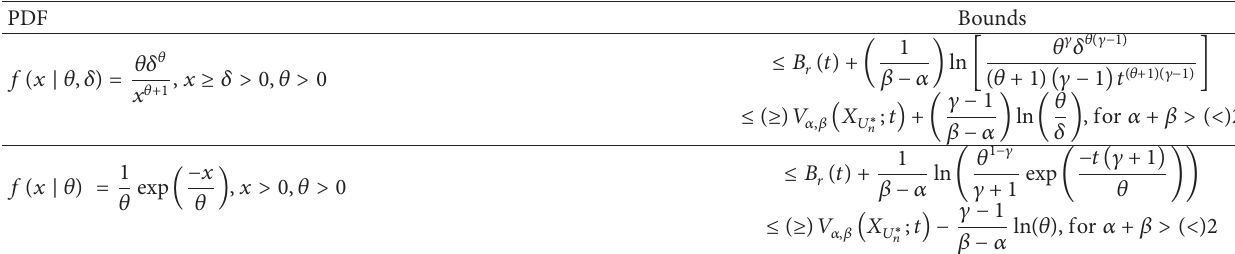
Table 2: Bounds of 𝑉 𝛼,𝛽 (𝑋 𝑈